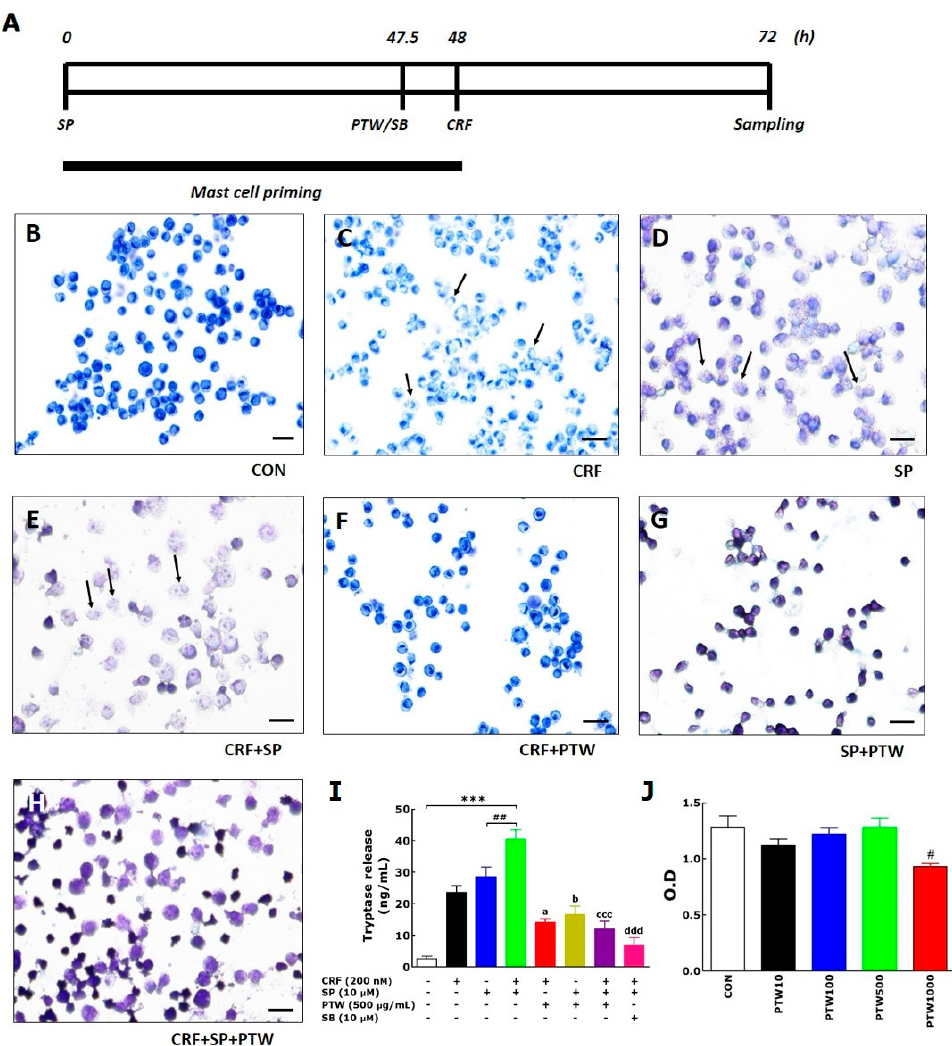
Figure 3. Schematic diagram showing in vitro experimental schedule ( A ) and representative images toluidine blue-stained HMC-1 cells treated with vehicle as a control (CON, ( B )); corticotrophin-releasing factor (CRF, ( C )); substance P (SP, ( D )); CRF + SP ( E ); CRF + Polygala tenuifolia Willd. (PTW, ( F )); SP + PTW ( G ) and CRF + SP + PTW ( H ); their tryptase levels ( I ) and cell viability ( J ) measured in the culture medium during degranulation. In the experiments of ( B – D ), cells were harvested for assay 24 h after vehicle (medium, CON), CRF and SP treatments, respectively. In ( F – H ), PTW was added 30 min before SP and/or CRF treatment, and the cells were harvested 24 h after SP or CRF treatment. The cells in H were harvested according to the in vitro experimental schedule in A with PTW